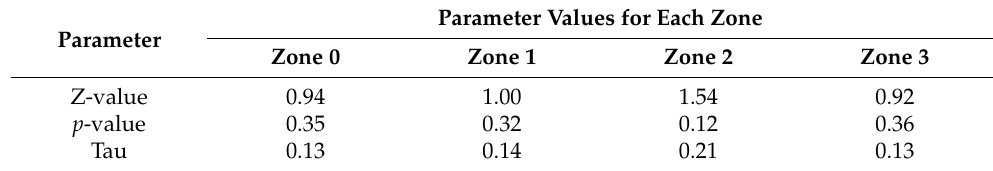
Table 8. Mann–Kendall Trend Test When Gridded Population Density is Considered. Parameter